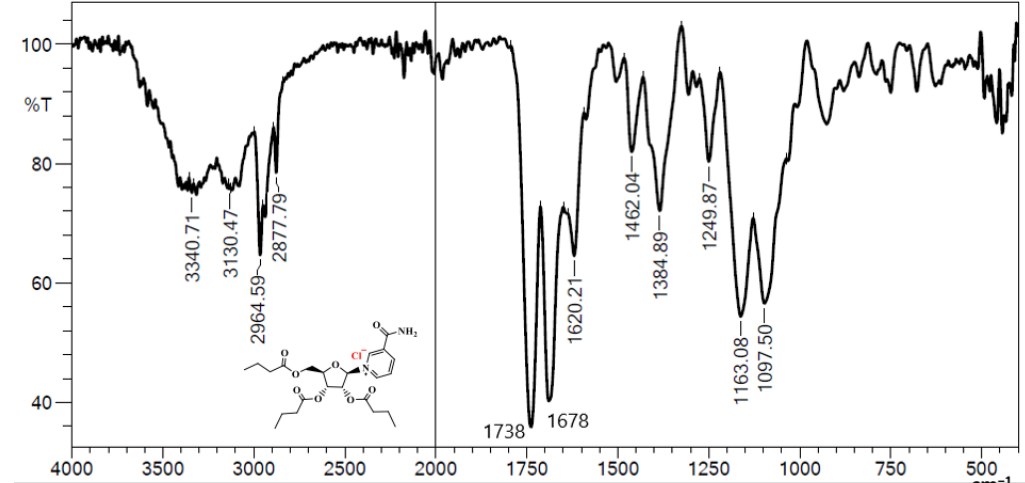
Figure 2. FTIR of